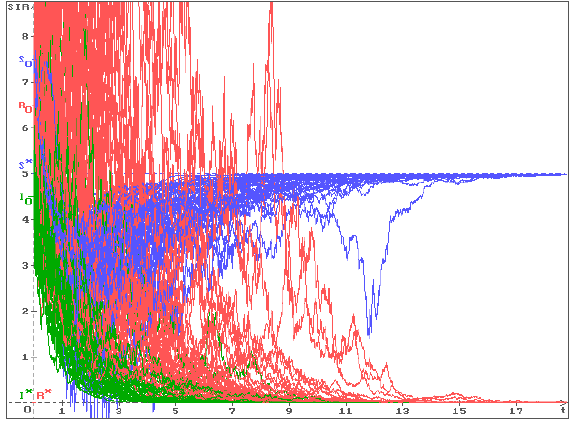
Figure 6. Fifty trajectories of the solution of the system (6) solution: S ( t ) (blue), I ( t ) (green), R ( t ) (red) with the initial values S ( 0 ) = 7.5, I ( s ) = 4.5, s ∈ [ − h ,0 ] , R ( 0 ) = 6.5 and δ 1 = 1.5, δ 2 = 2, δ 3 = 2, h =